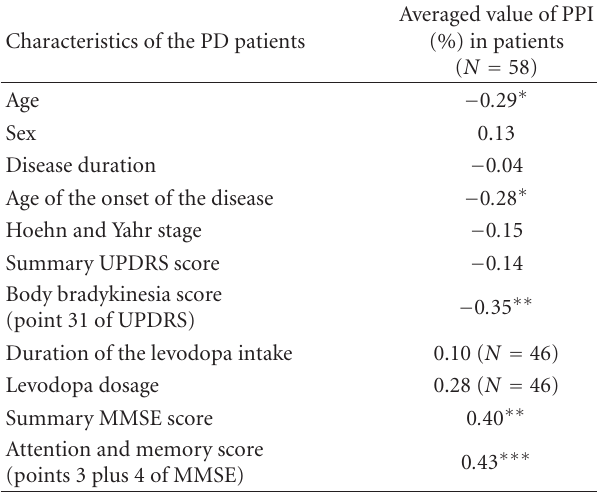
Table 3: Correlation coe ffi cients between the averaged value of the paired-pulse inhibition (PPI) and the characteristics of the PD